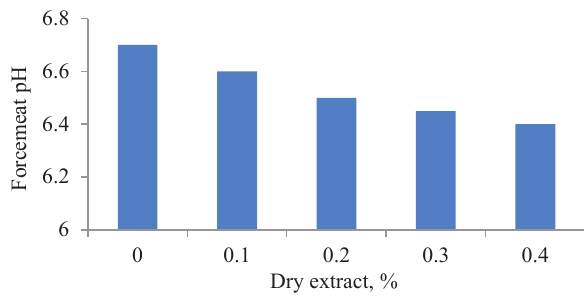
Figure 1 Amounts of dry lingonberry marc extract vs. forcemeat